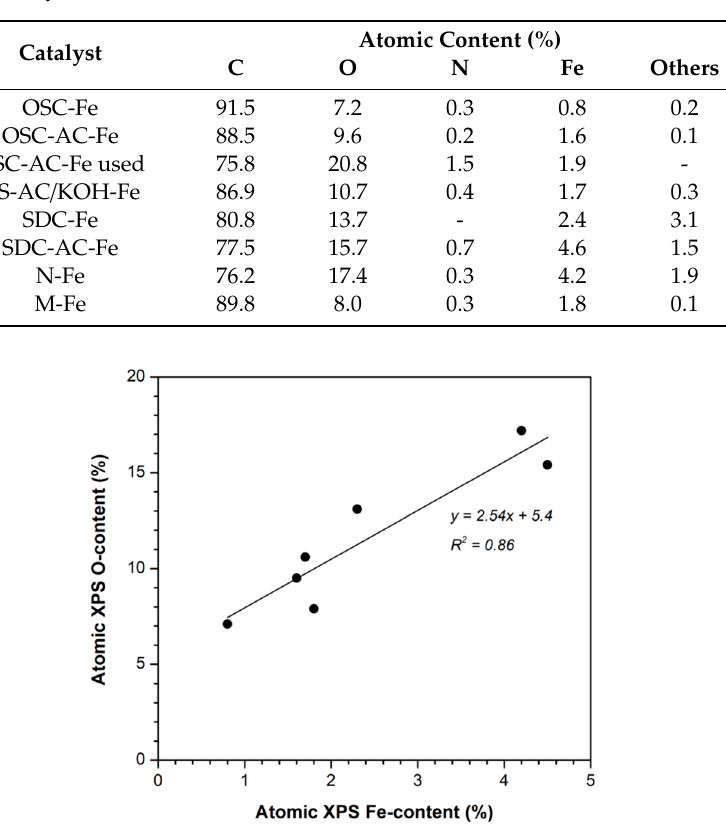
Figure 7. Relationship between the surface’s Fe and O atomic contents (%) for all the prepared